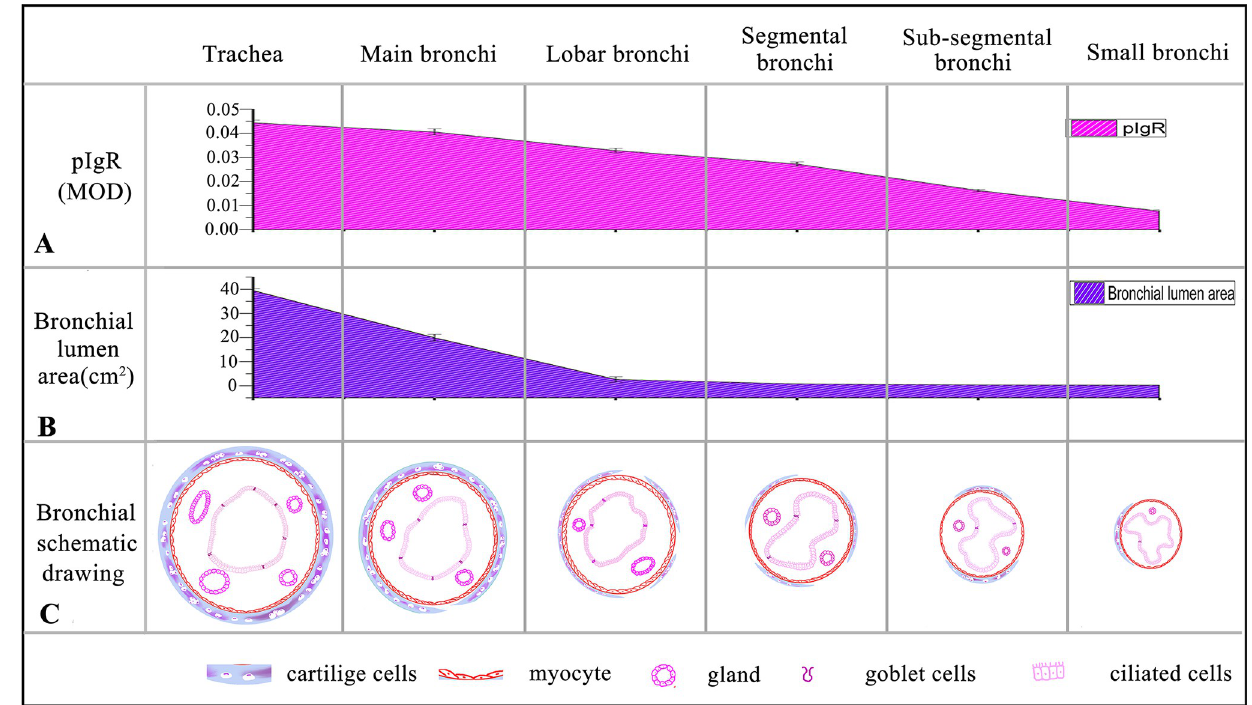
Fig 8. pIgR expression variation regularity in the ciliated epithelial cells of different graded bronchi in Bactrian camels.